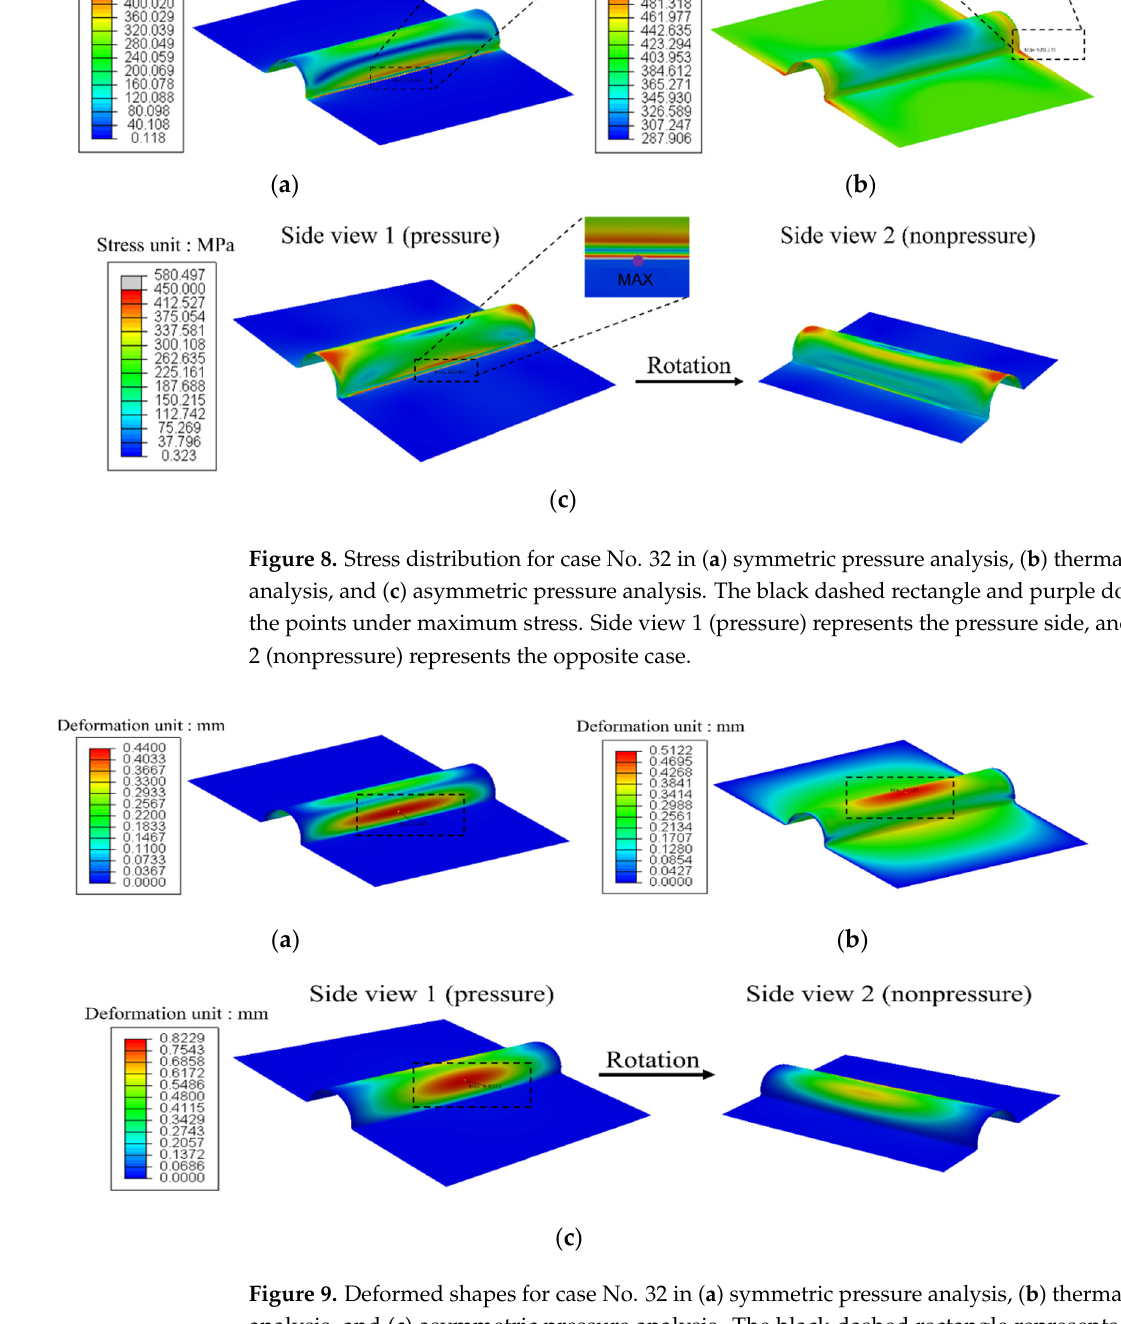
(d) Figure 9. Deformed shapes for case No. 32 in ( a ) symmetric pressure analysis, ( b ) thermal shrinkage analysis, and ( c ) asymmetric pressure analysis. The black dashed rectangle represents the area of